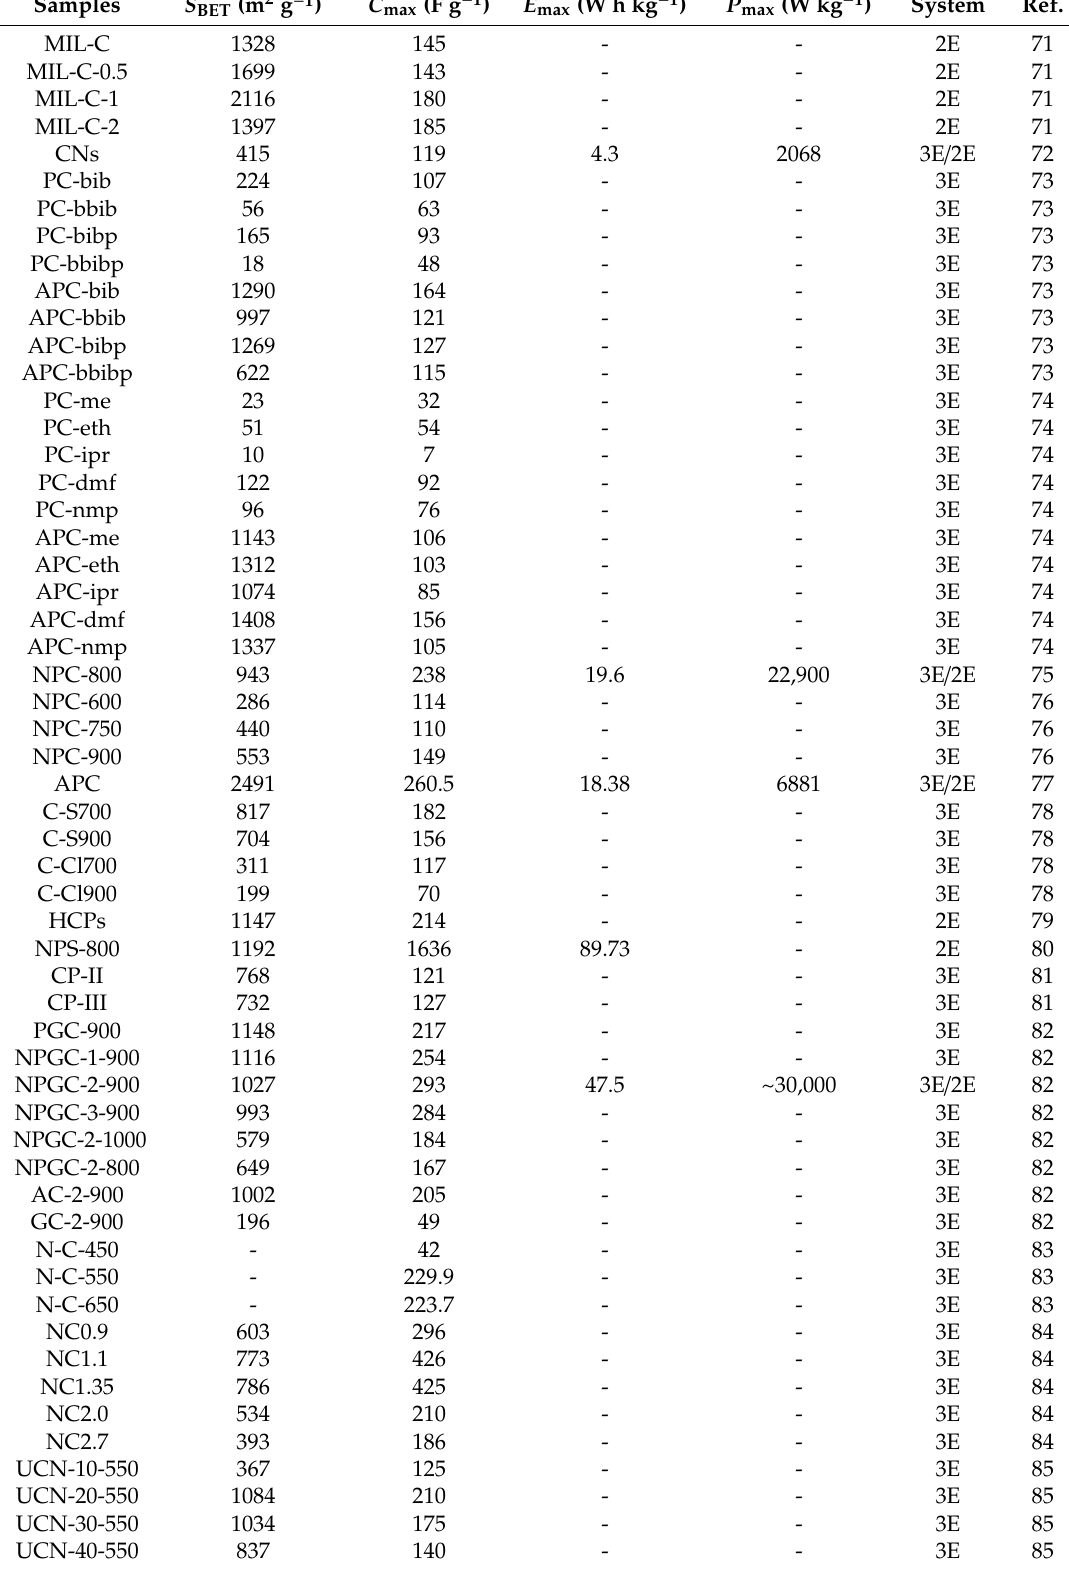
Table 4. The electrochemical capacitive performances of carbons derived from other types of MOFs.